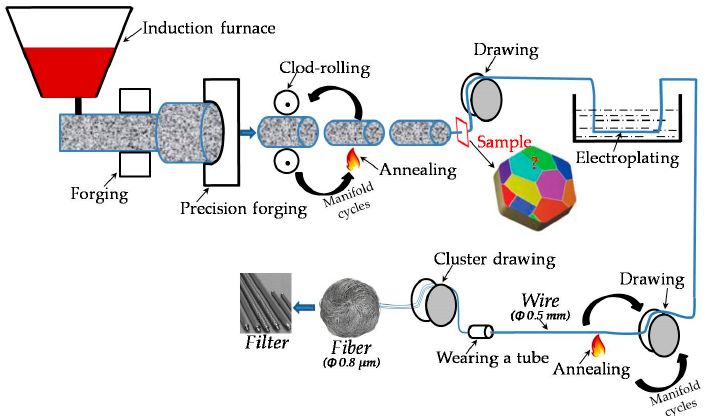
Figure 1. Schematic diagram from bar to wire and then to fiber.